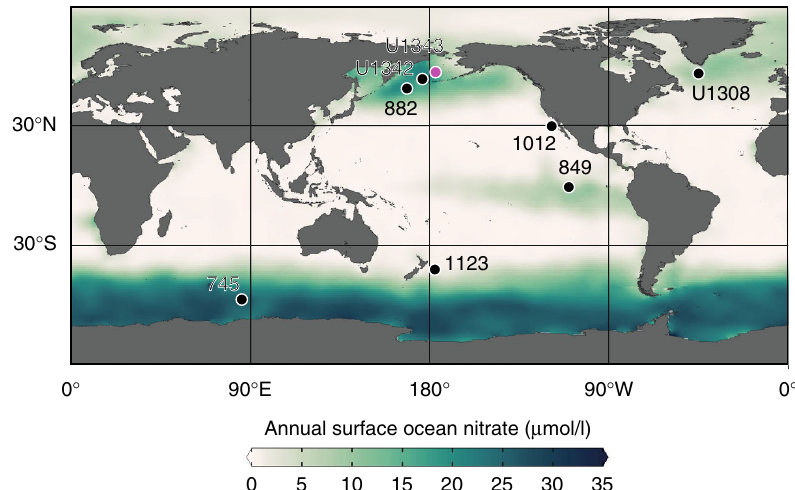
Fig. 1 Map of annual surface ocean nitrate concentration ( µ mol/l). Surface water data taken from the 2013 World Ocean Atlas database 67 . Circles show the locations of sediment cores referred to in the text. The new data in this paper come from Site U1343 (pink